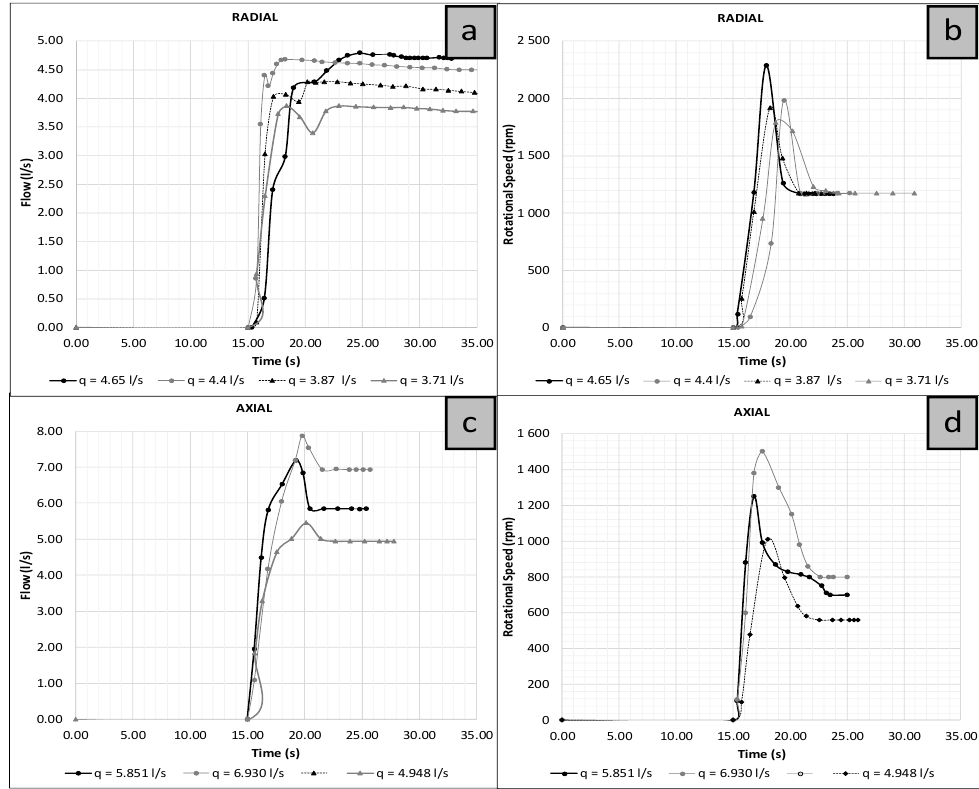
Figure 11. Experimental data recorded flow and rotational speed for the fast opening of the downstream control valve in turbine machines. ( a ) flow for radial machine ( b ) rotational speed for radial machine ( c ) flow for axial machine ( d ) rotational speed for axial machine.